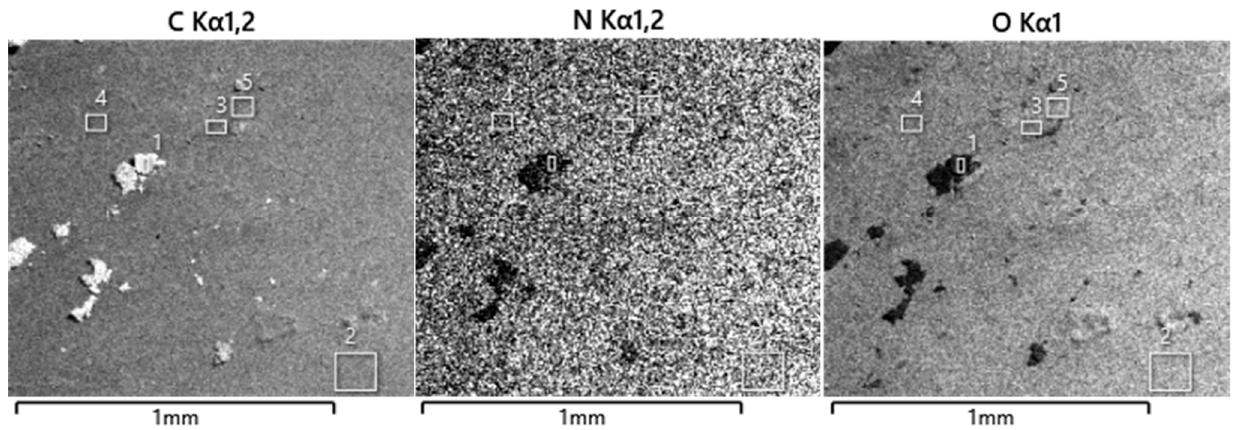
Figure 3. SEM images of CS-MB hydrogels: ( i ) CS film at 5000 × ; ( ii ) CS-MB at 5000 × ; ( iii ) CS-MB at 15,000 × ; ( iv ) CS-MB swollen in 5% w / v NaCl 500 × ; ( v ) CS-MB swollen in 5% w / v NaCl at 5000 × ; ( vi ) CS-MB swollen in 5% w / v NaCl at 60 × with visible NaCl on the surface.